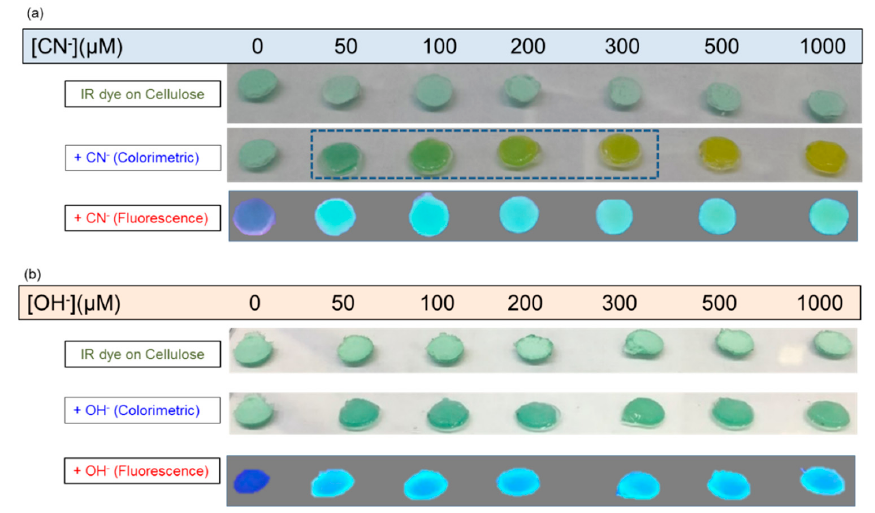
Figure 5. Real-color photographs of colorimetric and fluorescence emission from IR-786 dried on to solvent-free solid surfaces before and after the addition of ( a ) CN − and ( b ) OH − .